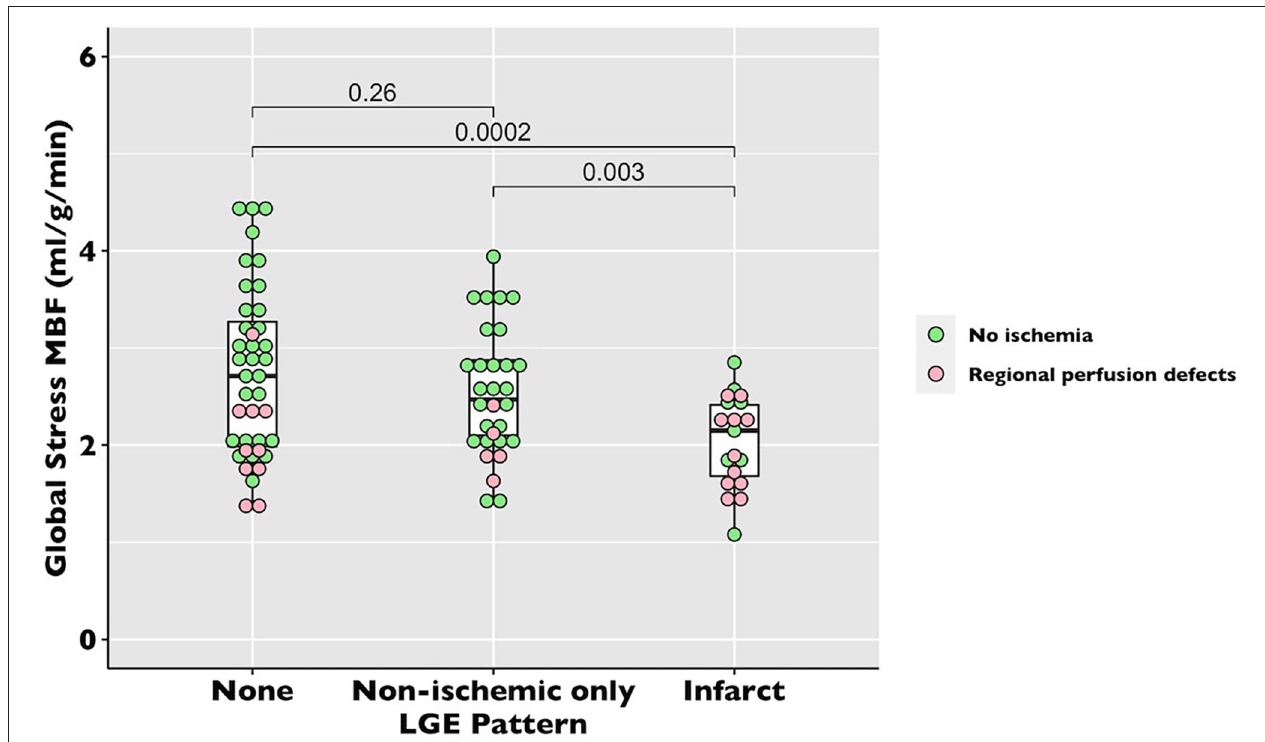
FIGURE 4 | Global stress MBF in recovered post-COVID-19 patients by late gadolinium enhancement (LGE) pattern. The dot plot of global stress MBF by perfusion pattern. Each dot represents a patient. The pink dots represent the patients with unmatched regional perfusion defects by visual assessment. The green dots represent the patients with no regional perfusion defects.